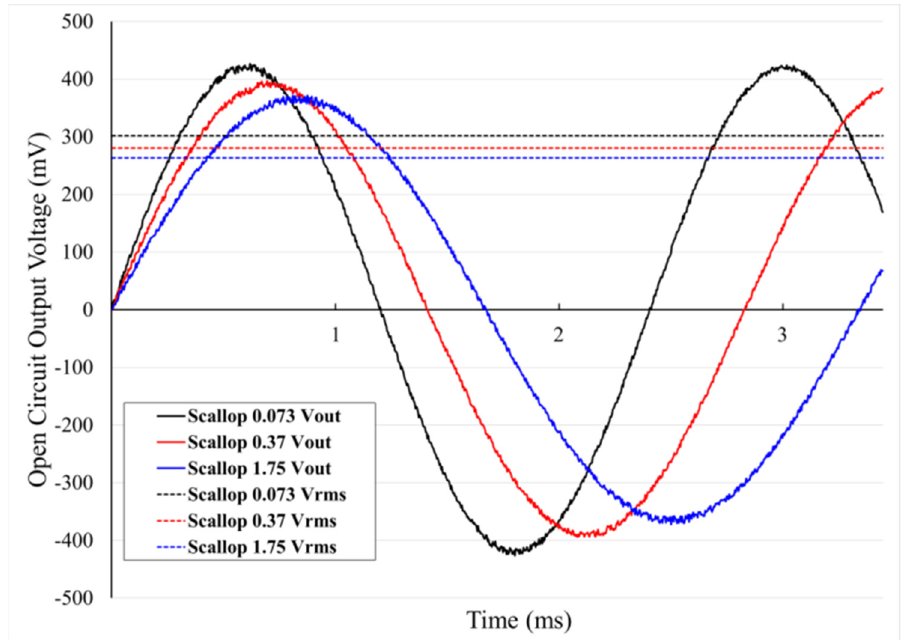
Figure 10. Measurement results of open circuit output voltage according to different sizes of the scallops (pressure = 20 psi).